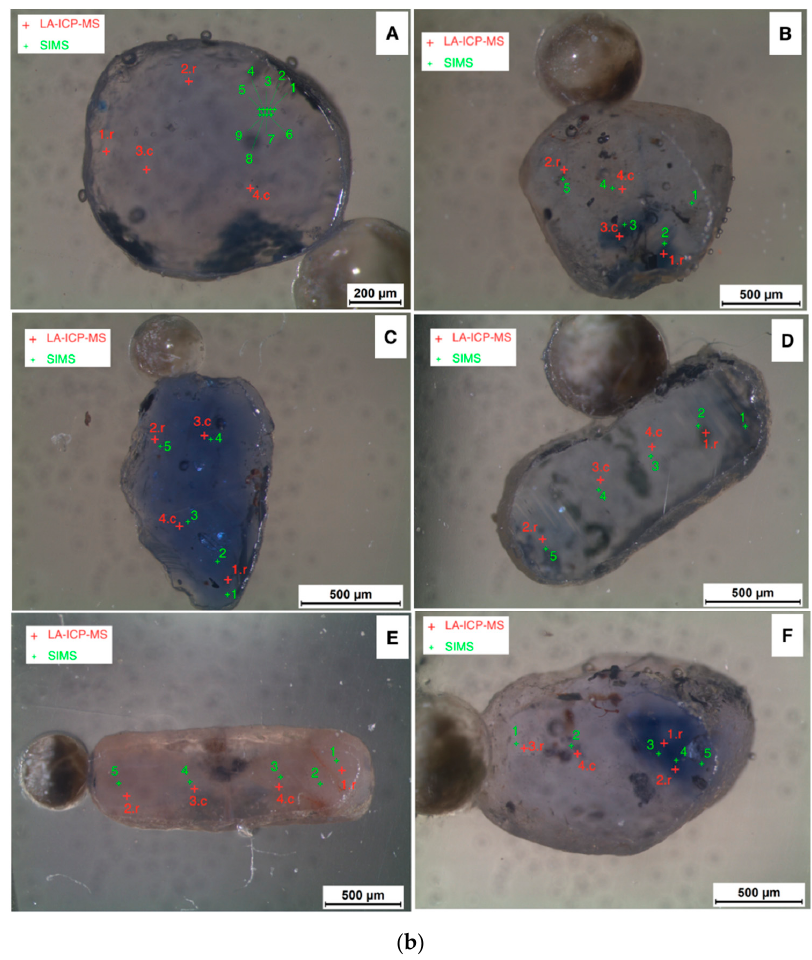
Figure 2. Images of the analyzed sapphires with both LA–ICP–MS and SIMS analysis spots indicated ( a ). A = AC ‐ 1, B = AC ‐ 2, C = AC ‐ 3, D = AC ‐ 4, E = AC ‐ 5 and F = AC ‐ 7. ( b ) A = AC ‐ 10, B = AC ‐ 11, C = AC ‐ 13, D = AC ‐ 14, E = AC ‐ 15 and F = AC ‐ 16).